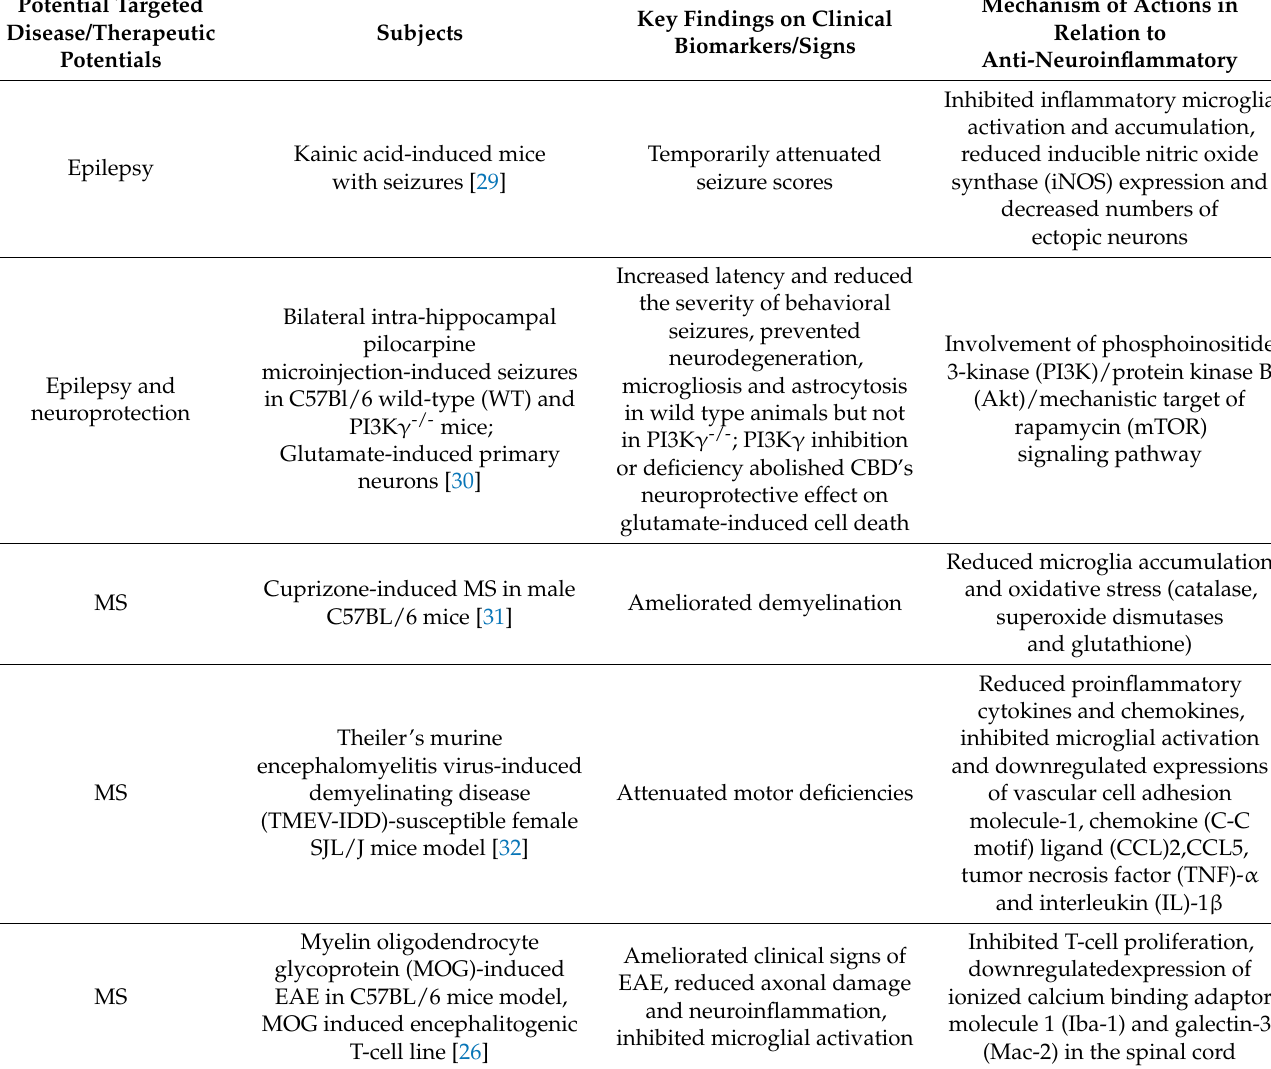
Table 1. A summary of preclinical evidence of CBD on microglial activation and neuroinflammatory